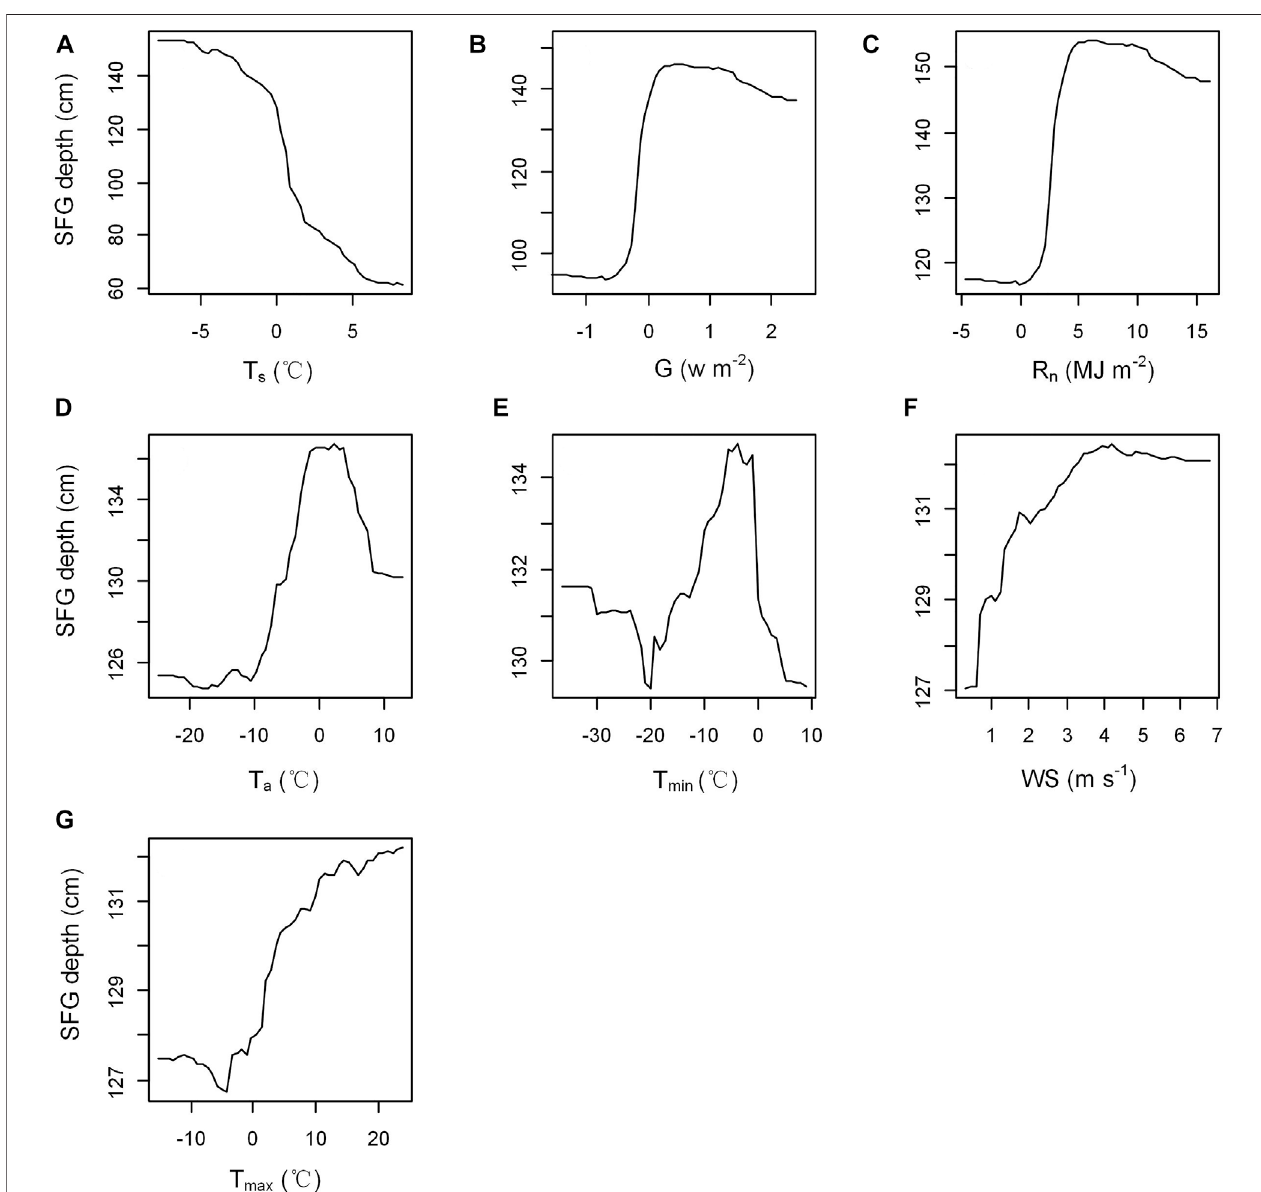
FIGURE 8 | Partial effect of environmental factors on seasonally frozen ground depth, (A) average soil temperature, (B) soil heat fl ux, (C) net radiance, (D) average air temperature, (E) minimum air temperature, (F) average wind speed, and (G) maximum air temperature.